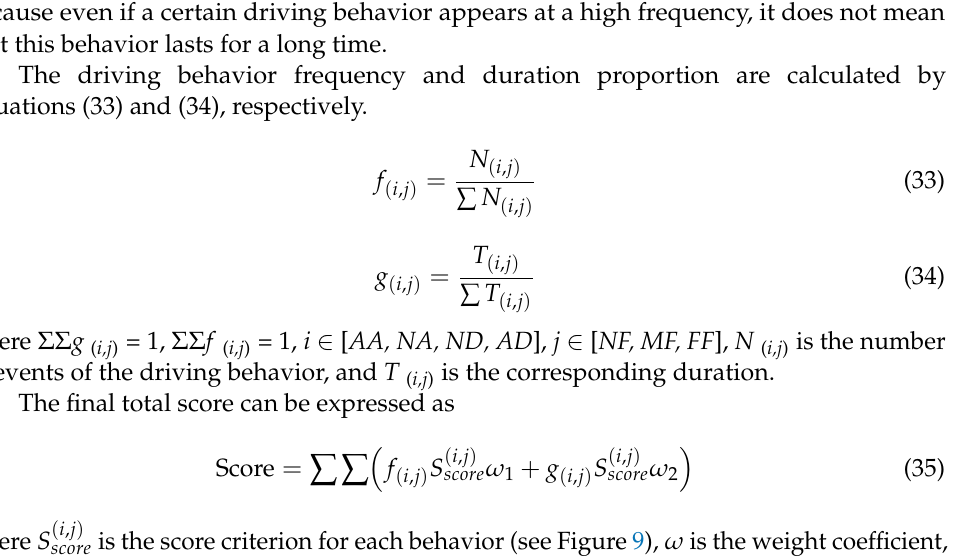
Figure 11. The segmentation results of the driving behavior of driver #5 in one following event, ( a ) the sequence clusters of the driving behavior, ( b ) the fragments result of THW, ( c ) the fragments result of acceleration. Figure 11a shows the sequence clusters of the driving behavior. The same color or the same number represents the same driving behavior. For example, the number 0 and the number 19 represent two different driving behaviors. In Figure 11b,c, it can be found that THW and acceleration have similar characteristics. For “0” driving behavior, the cor- responding THW is near 2 s, and the acceleration is about 0.5 m/s 2 . For “19” driving be- havior, THW is near 2.1 s, and the acceleration is about 0.8 m/s 2 . Additionally, the duration of each driving behavior is different, which shows that HDP–HSMM can identify the driv- ing behavior from time series data according to the data characteristics without subjective intervention. Furthermore, the data fragments with similar features are automatically classified into one class. From above analysis, it is concluded that HDP–HSMM can effectively divide the driving process into different fragments. However, the fragments are still time series data clusters (Figure 12). It is not easy to quantify the driver risk indices. In fact, the quantifi- cation of a driver’s risk is more important than classification when the safety of a driver is evaluated. Herein, an analysis method of the driving style is proposed based on the driving behavior semantic plane in order to evaluate the safety of a driver accurately.